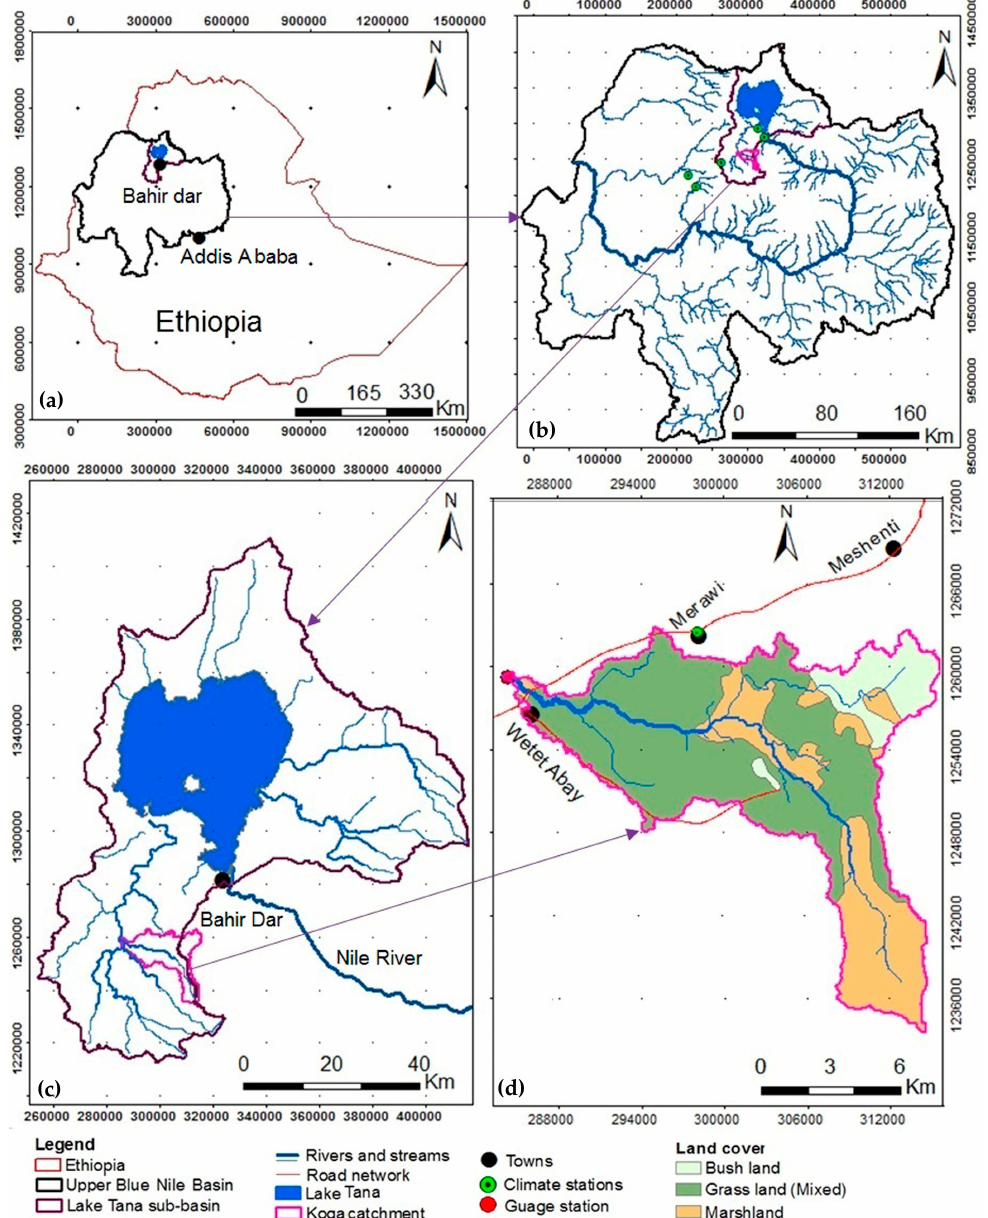
Figure 1. Location map of the study area: ( a ) geographical setting of the upper Blue Nile river basin in the country map; ( b ) network of rivers in the upper Blue Nile river basin; ( c ) Lake Tana sub-basin and its tributary river network; and ( d ) land use units in the study area.